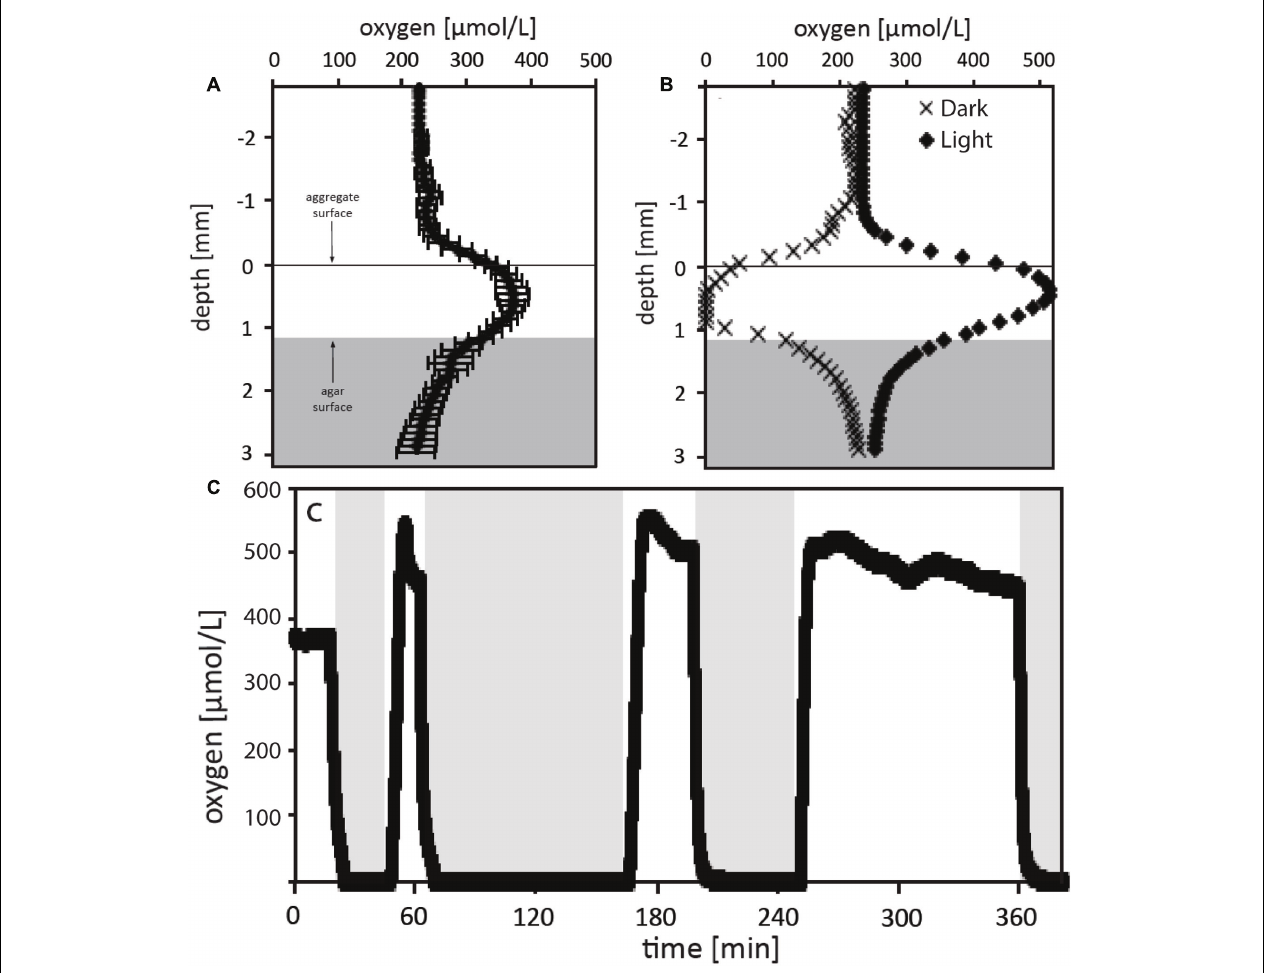
FIGURE 5 | Oxygen measurements of the green berry aggregates in light and dark conditions. (A) Depth microprofiles with oxygen microsensors were conducted for 3 similar aggregates under steady state illumination with 170 µ E m − 2 s − 1 . The average O 2 concentration versus depth relative to aggregate surface is plotted for these aggregates. (B) O 2 profiles were measured for an aggregate under conditions of steady state illumination at 320 µ E m − 2 s − 1 (black diamonds) and steady state darkness (black Xs). (C) The O 2 microsensor was positioned at the center of an aggregate which was then exposed to series of different illumination conditions over a time course while concentration was monitored. Initial conditions recorded were at 170 µ E m − 2 s − 1 followed by shift to darkness, and three subsequence rounds of illumination at 320 µ E m − 2 s − 1 followed by dark shifts. Dark periods are indicated by the position of the light gray